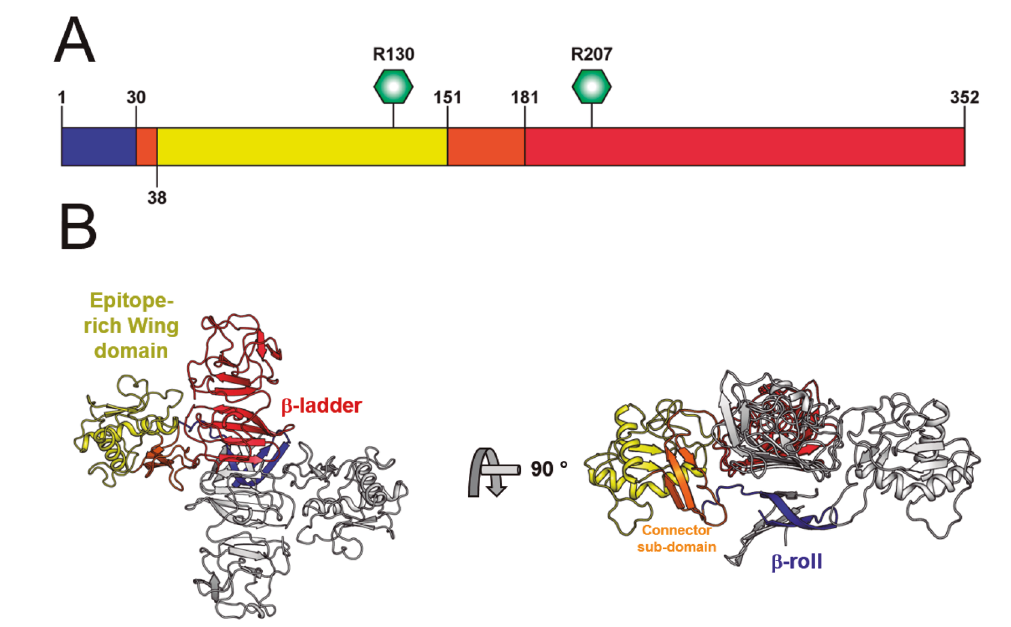
Figure 2. (A) Domain organization of NS1. Glycosylated residues R130 and R205 are identified by hexagons. (B) X-ray crystal structure of ZIKV NS1 dimmer (PDB ID:5GS6). ZIKV domains are colored following the color pattern of panel A